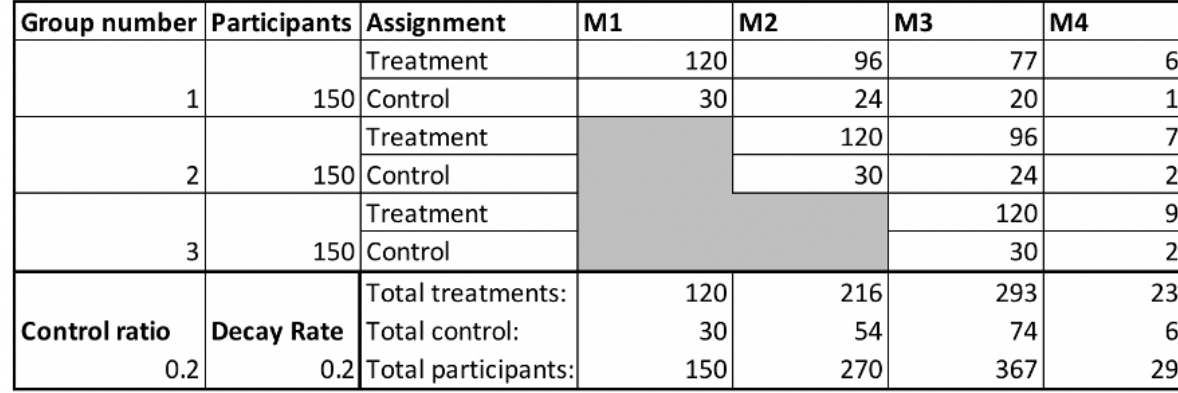
Figure 2. Panel size over time, including recruitment of participants, as well as the number of assigned participants in the treatment and control groups. We use a control ratio of 0.2 and a monthly decay rate of